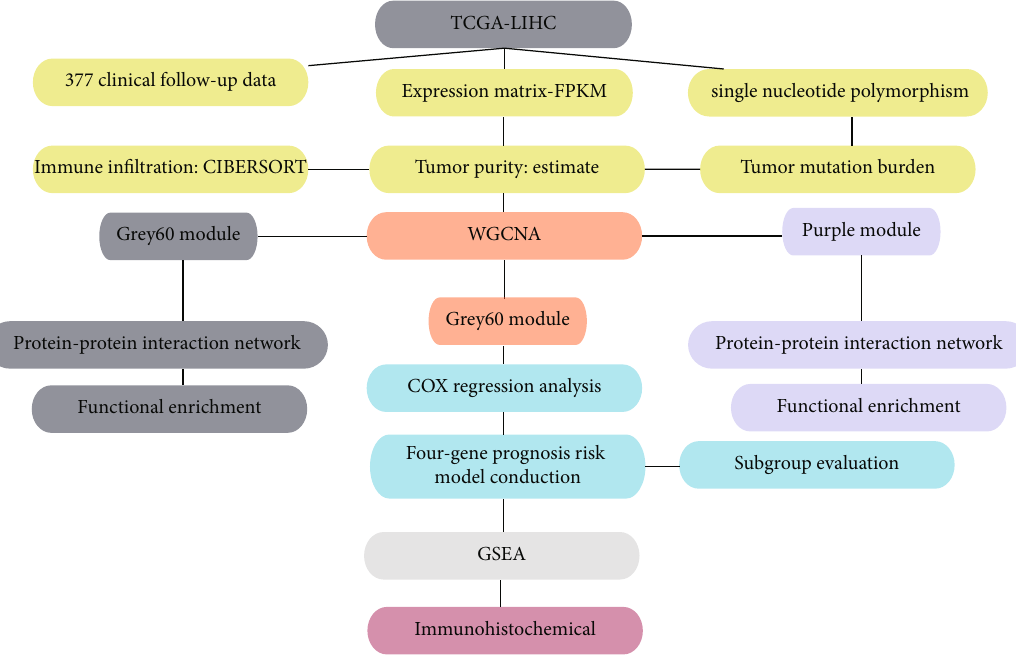
Figure 1: Flow chart of this